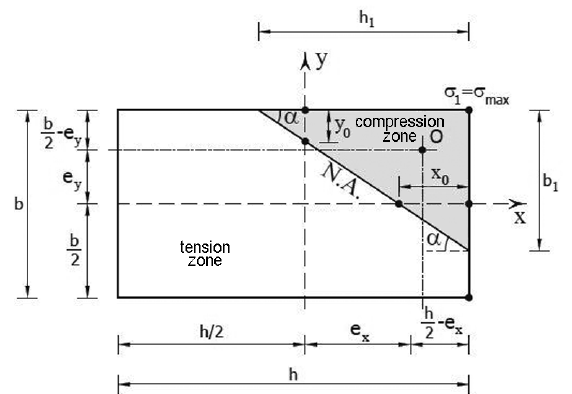
Fig. 8. Soil pressure distribution in rigid rectangular footing for the Case